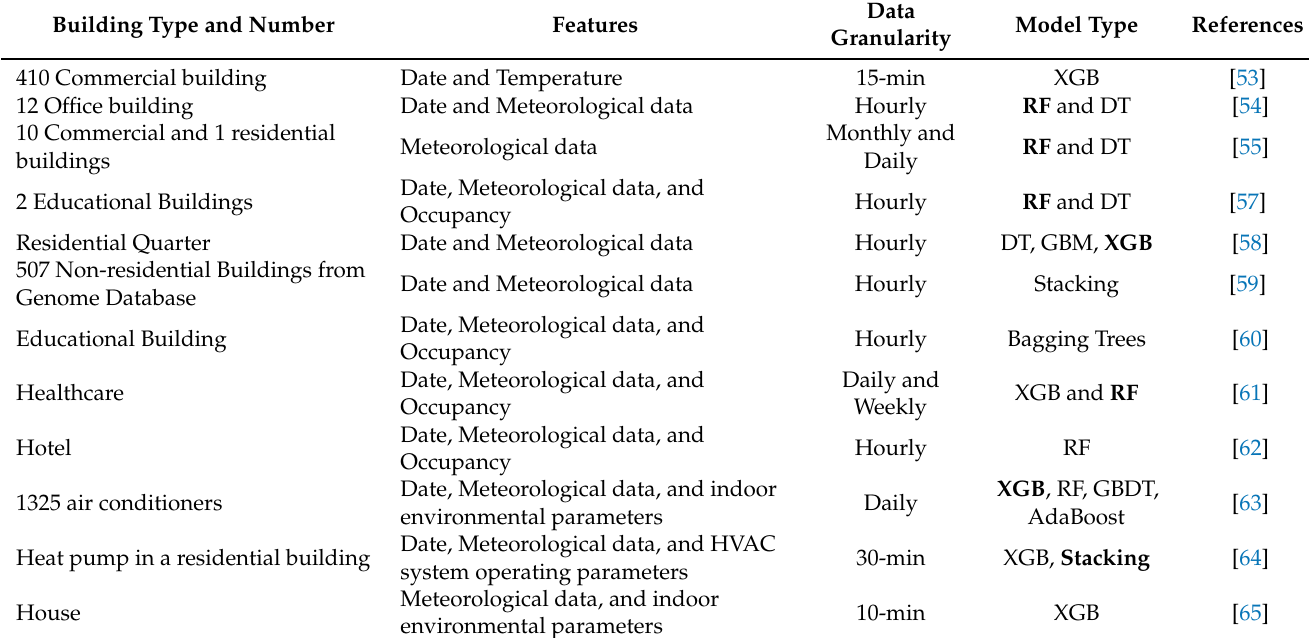
Table 3. Decision tree and ensemble cases that are applicable to M&V analysis and utilize real historical